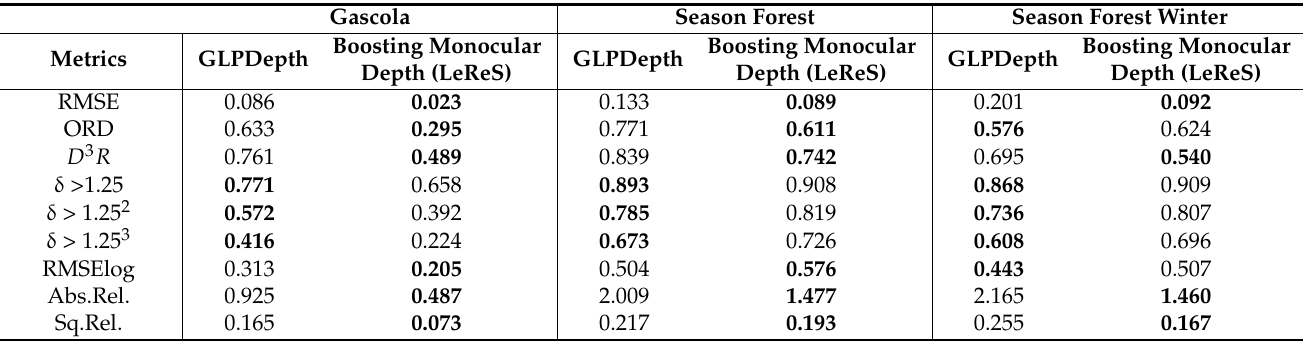
Table 6. Comparison results of depth estimation on the three trajectories (Gascola, Season Forest, and Season Forest Winter); the values in bold are the best results using GLPDepth and Boosting Monocular Depth (LeRes).